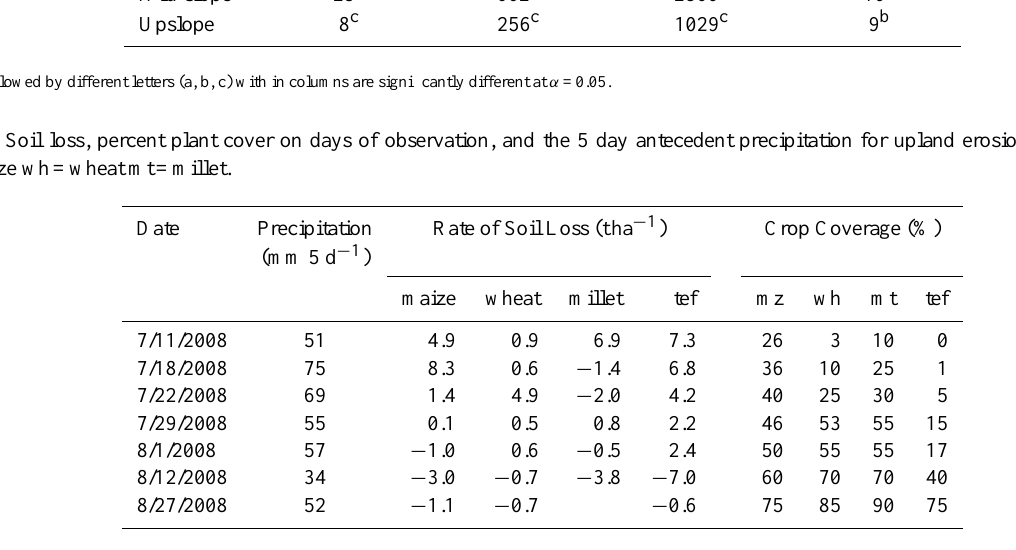
Table 2. Soil loss, area affected, rill density, and slope percent for the three different slope positions. Means with different letter within a column are significantly different based on a paired t-test at α =0.05. Soil Erosion Effect Erosion Factor Slope Position Soil loss Area of actual damage Rill density Slope (tha − 1 ) (m 2 ha − 1 ) ∗ Down slope 34 a 884 a 4946 a 14 a Mid-slope 23 b